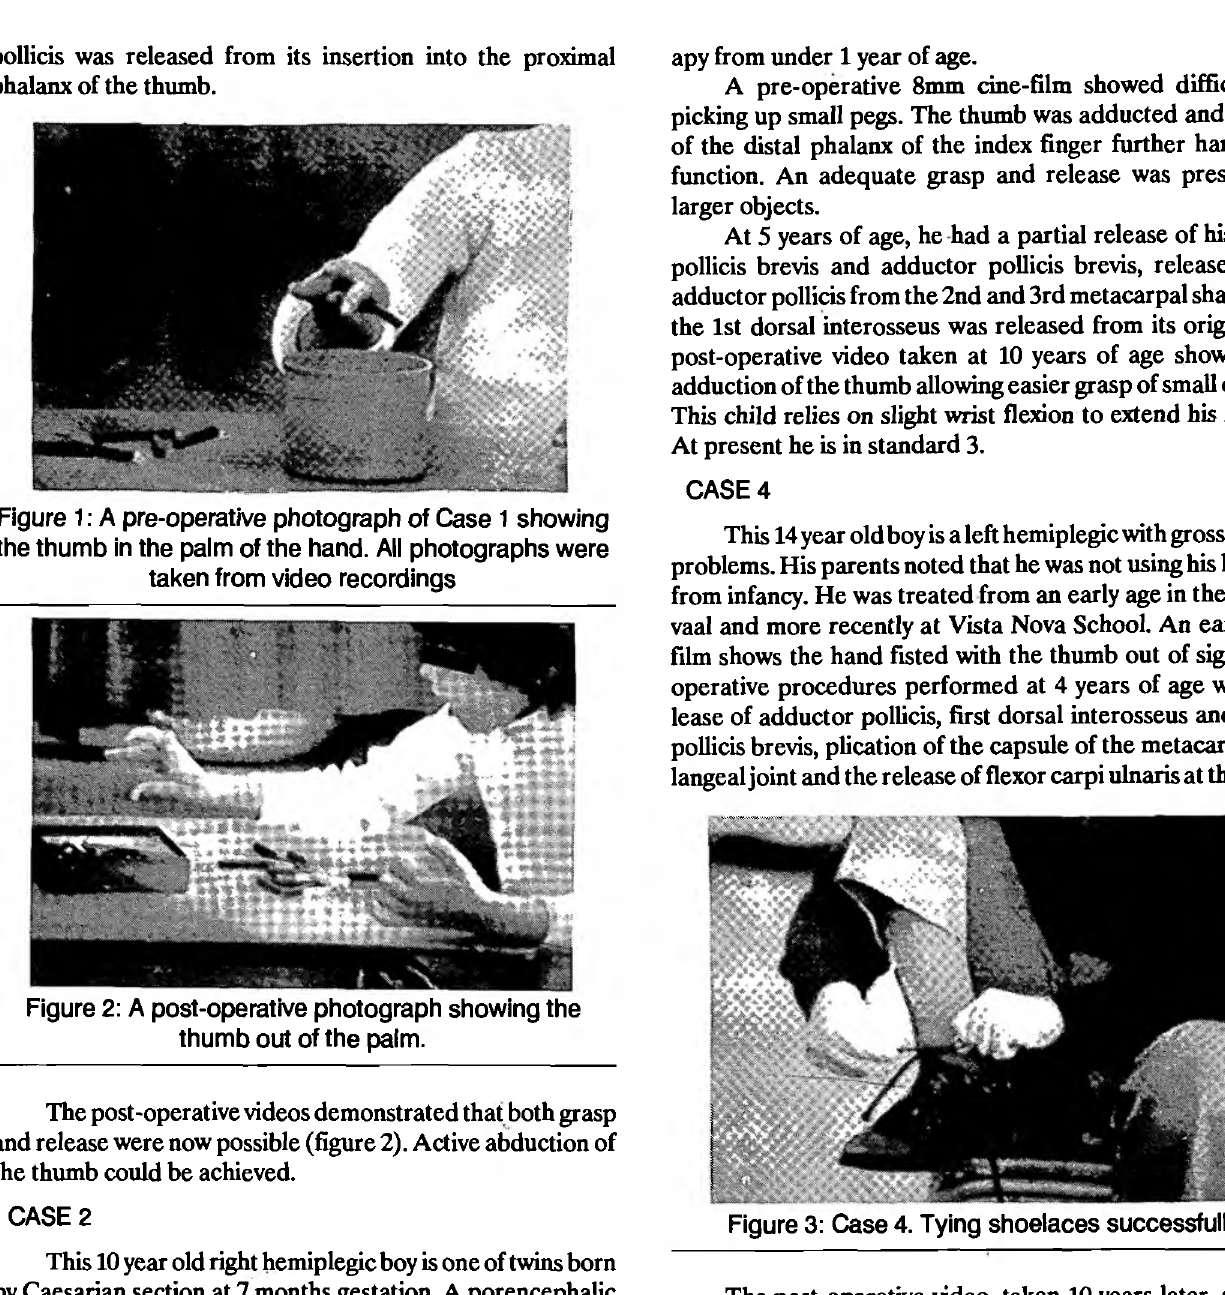
Figure 3: Case 4. Tying shoelaces